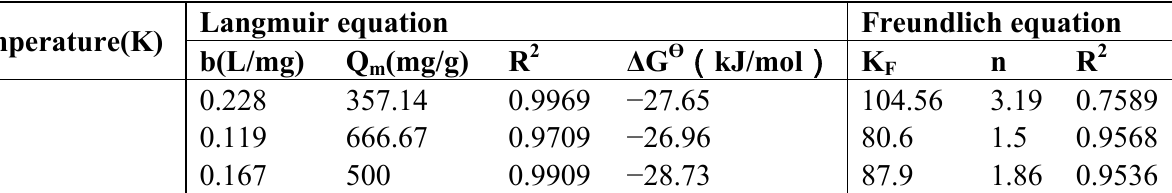
Table 1. Langmuir and Freundlich isotherm parameters for three different